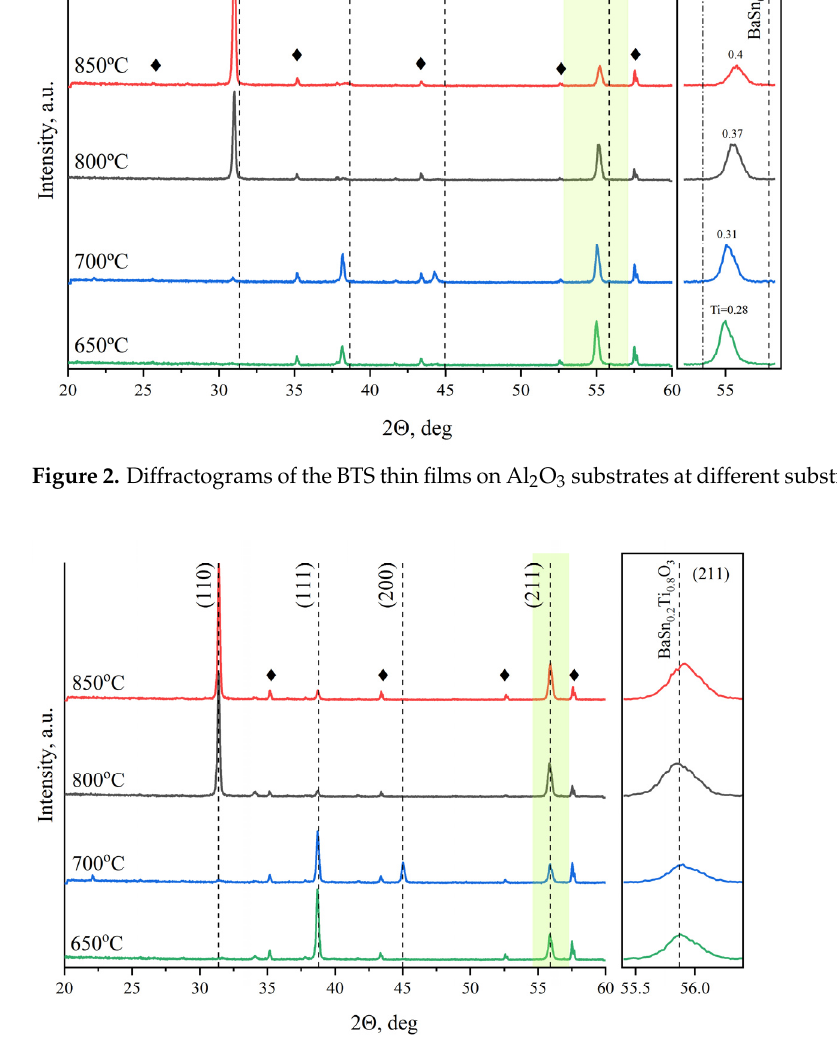
Figure 2. Diffractograms of the BTS thin films on Al 2 O 3 substrates at different substrate temperatures.